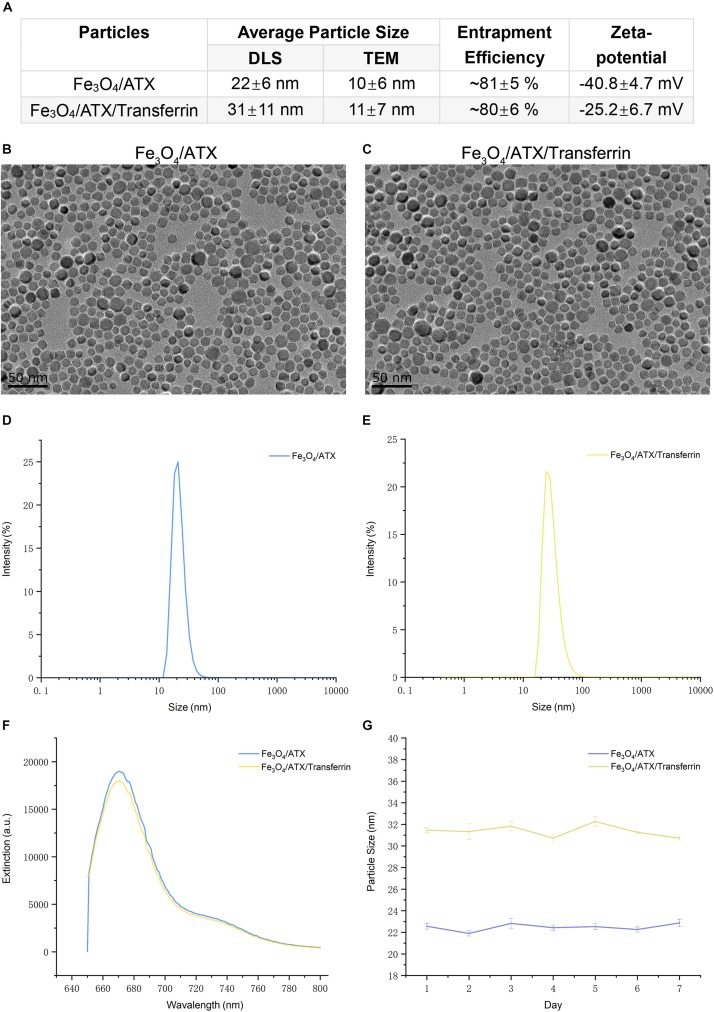
Physicochemical characteristics of ATX-NPs. (A) The average particle size, entrapment efficiency, and zeta-potential of ATX-NPs. (B,C) Representative TEM pictures of ATX-NPs. (D,E) Dynamic laser scattering (DLS) measurement of hydrodynamic size distribution of ATX-NPs. (F) Fluorescence emission spectra of ATX-NPs. (G) Particle size of ATX-NPs during 7 days storage at 4°C. The values represent the mean ± SEM.